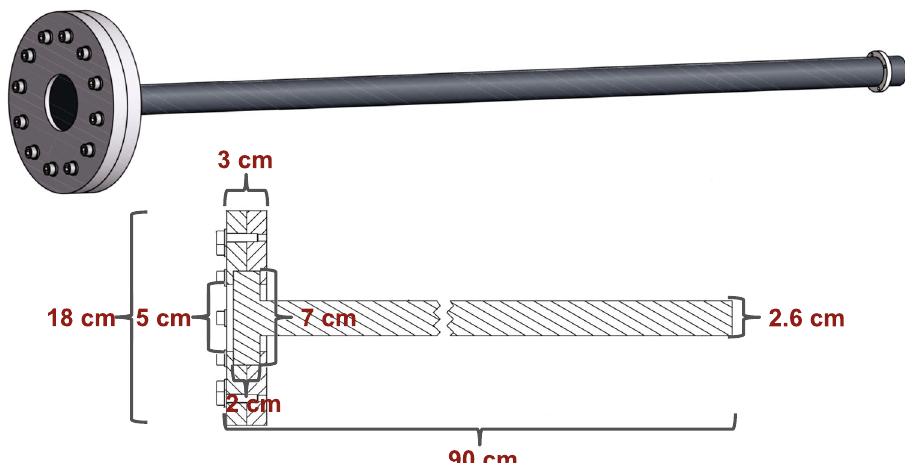
Fig. 2 The T2K replica target with aluminium flange attached to the upstream disk. The hole at the upstream side of the flange was used for the S 3 counter. A technical drawing of the T2K replica target with the upstream flange zoomed in is shown on the bottom of the